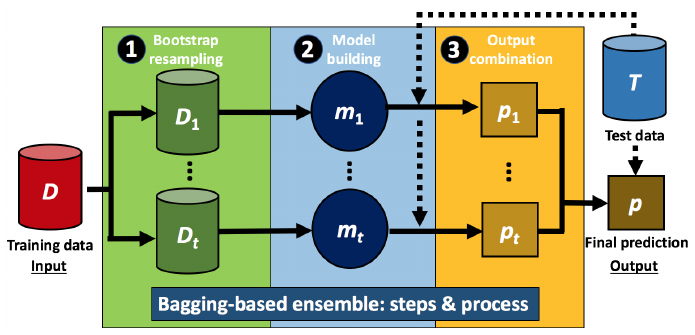
Figure 1. Main steps of bagging-based